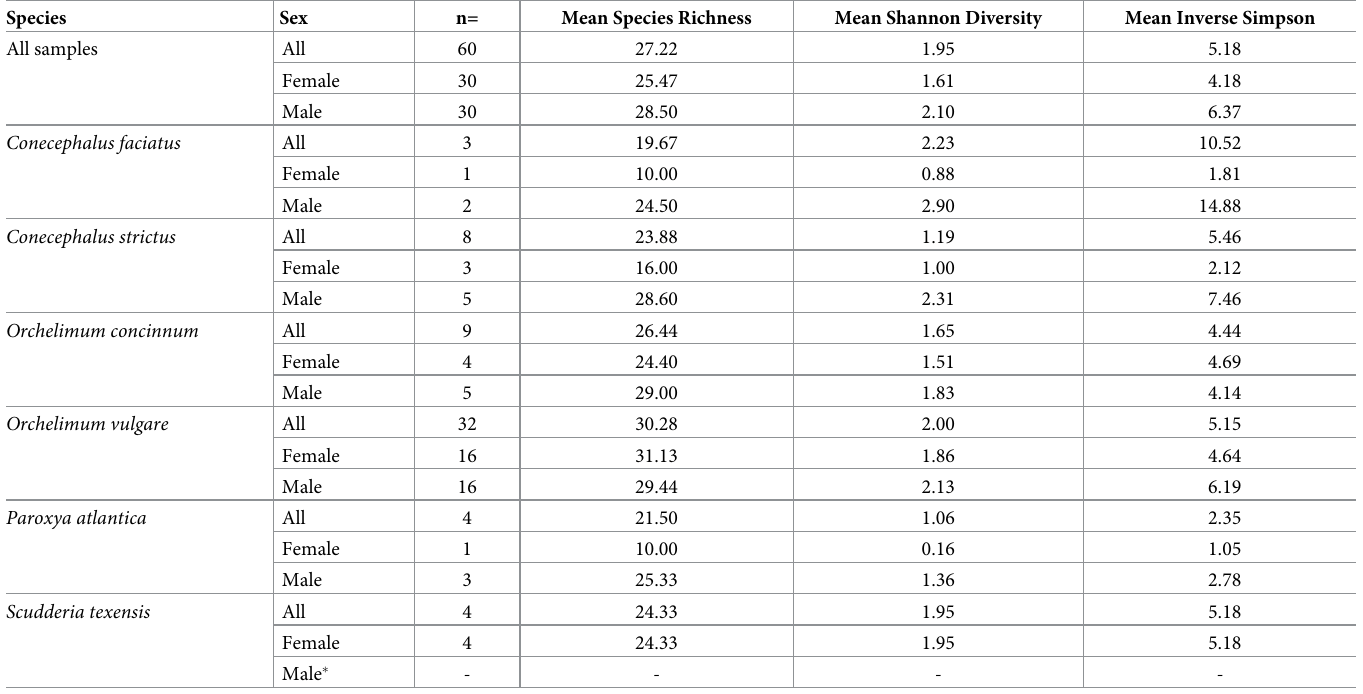
Table 1. An overview of sample distribution and